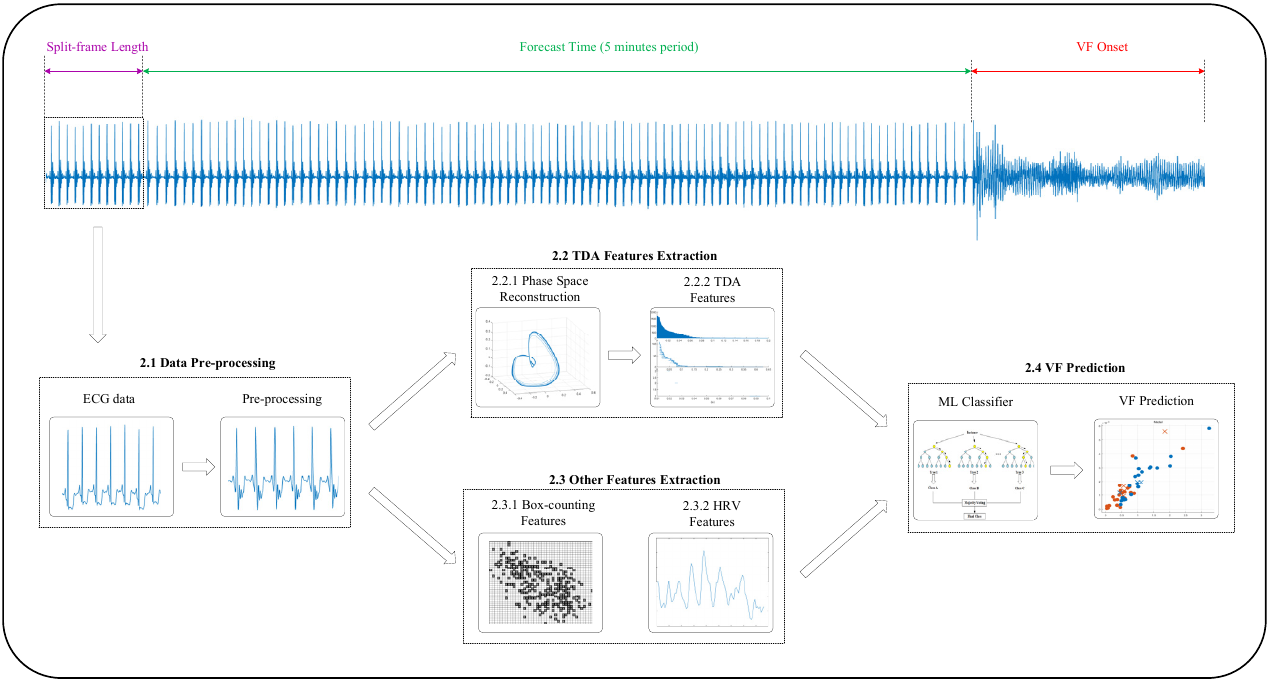
Figure 1. Workflow of the proposed method for prediction of VF. Table 1. Sixty selected ECG records from CUDB, SDDB, and